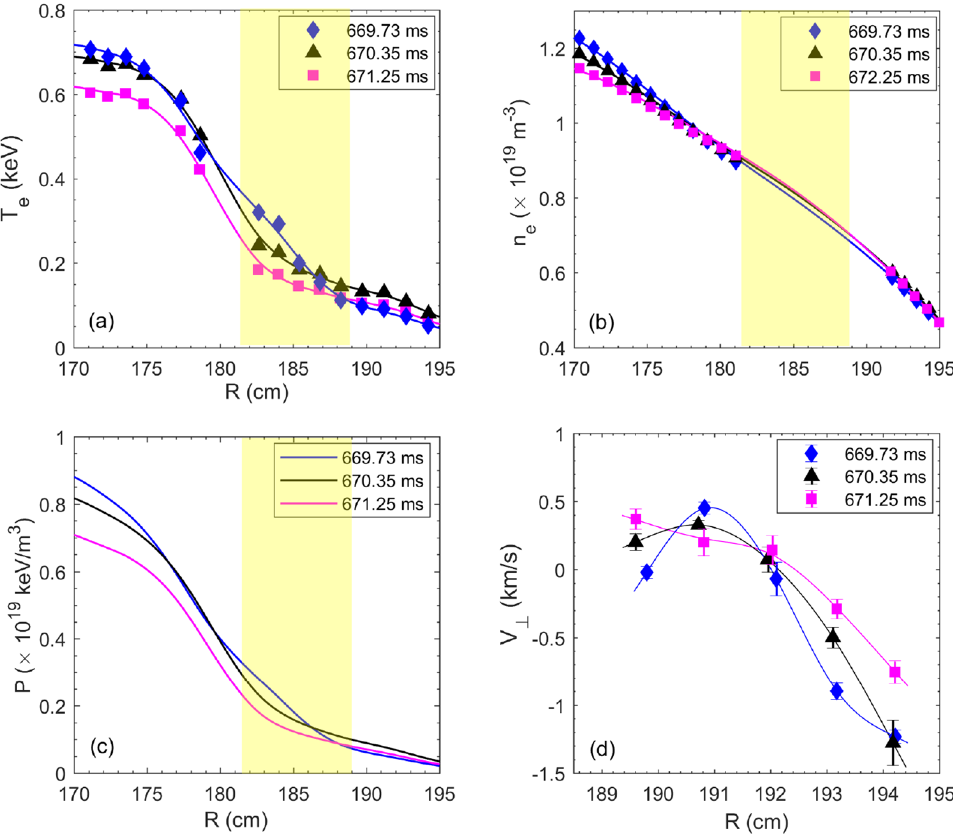
Figure 11. Radial profiles of ( a ) T e , ( b ) n e , ( c ) electron pressure P and ( d ) the perpendicular rotation velocity ( V ⊥ ) across the island X-point at 669.73 ms, 670.35 ms and 671.25 ms, respectively. The symbols are measured data points, and the curves are from the fitting of measured data points (#33432).